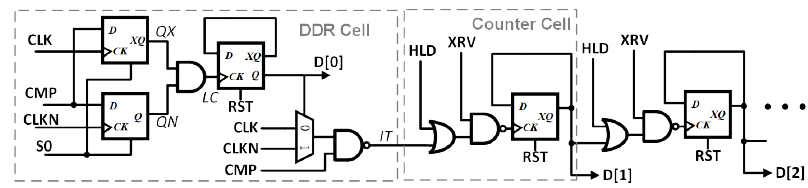
Figure 11. Block diagram of the flip-reduced up/down DDR counter.